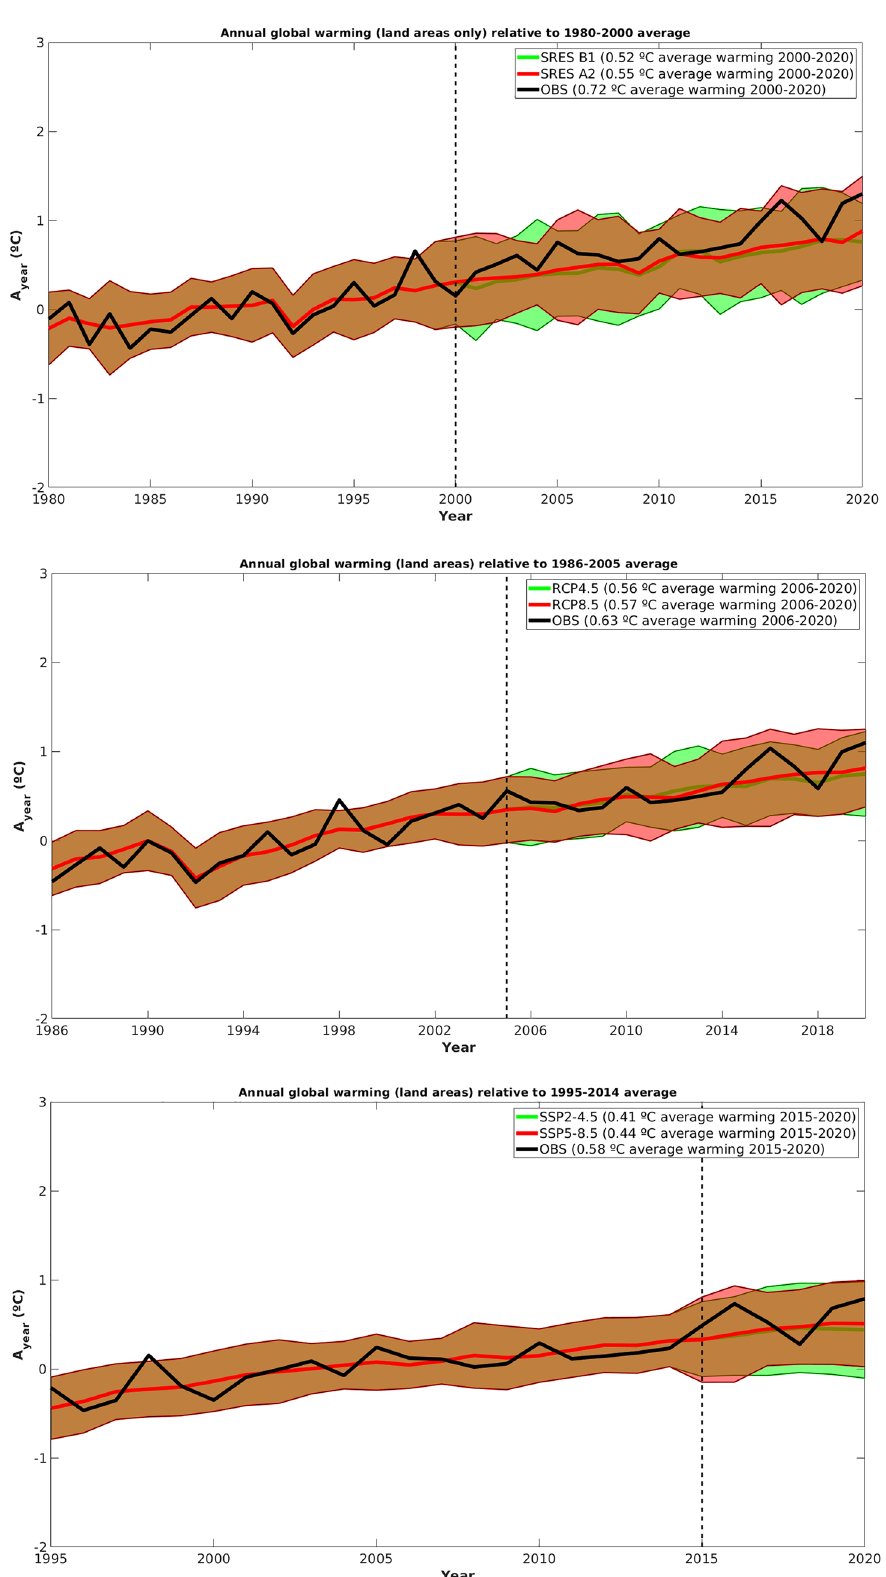
Figure 1. Annual global warming (land areas only) relative to the reference period: top panel for CMIP3, middle panel for CMIP5 and bottom panel for